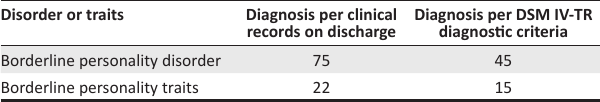
TABLE 1: Comparing borderline personality disorder diagnoses made from clinical data with DSM IV-TR diagnostic criteria of Helen Joseph Hospital psychiatric inpatients, 2010. Disorder or traits Diagnosis per clinical Diagnosis per DSM IV-TR records on discharge diagnostic criteria Borderline personality